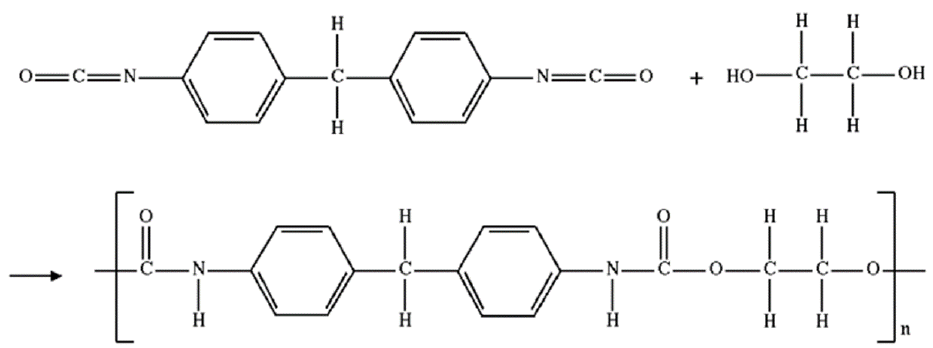
Figure 2. Simplified general formula for polymer production.